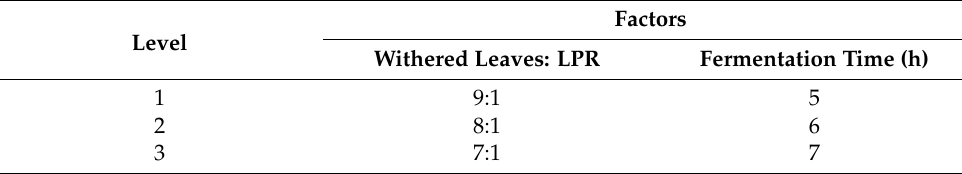
Table 1. Orthogonal test